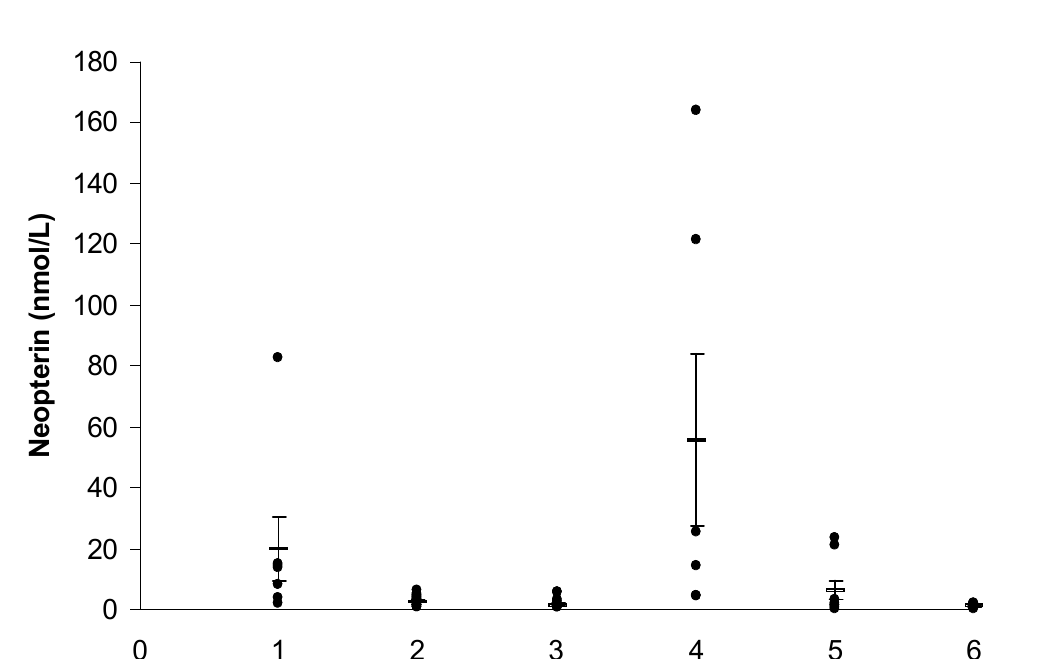
Figure 1. CSF neopterin in different groups of patients. CSF neopterin concentrations in patients with NHL (1), other tumors (2), predominantly peripheral infections (3), meningitis or encephalitis (4), multiple sclerosis or polyneuropathies (5), or no infectious, inflammatory or neoplastic disorders (control group; 6). The means are indicated by horizontal bars, and the error bars indicate standard error of the